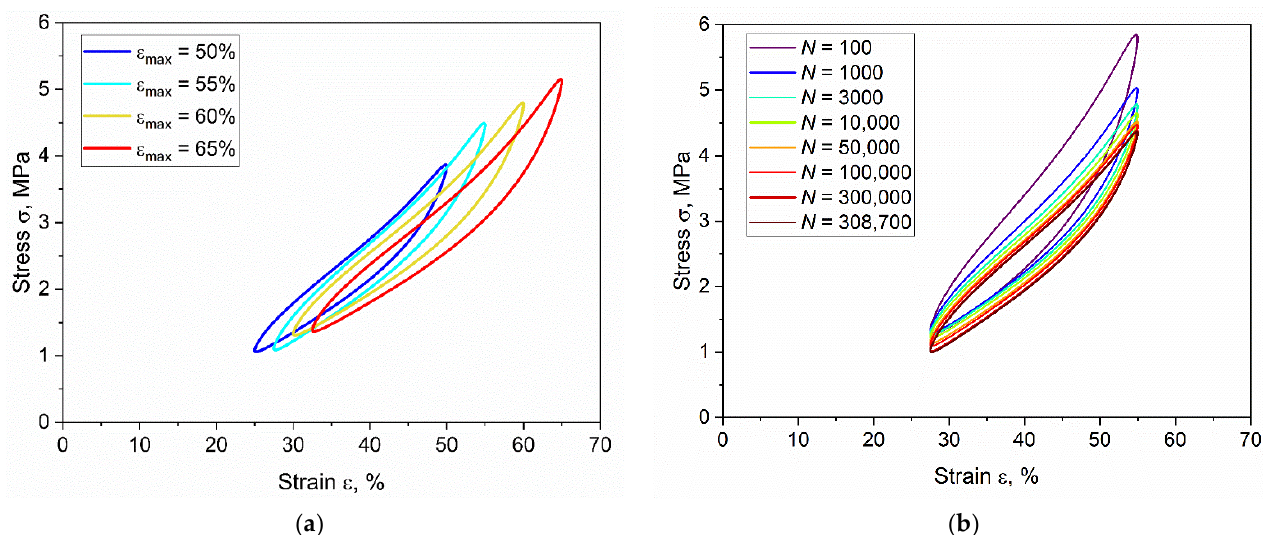
Figure 5. ( a ) Hysteresis curves at different maximum strains at 3000 cycles; ( b ) evolution of hysteresis curve at different number of cycles for maximum strain ε max of 55%. The fatigue tests were implemented on axisymmetric dumbbell specimens of CB filled NBR at frequency of 4 Hz and load ratio R ε of 0.5.